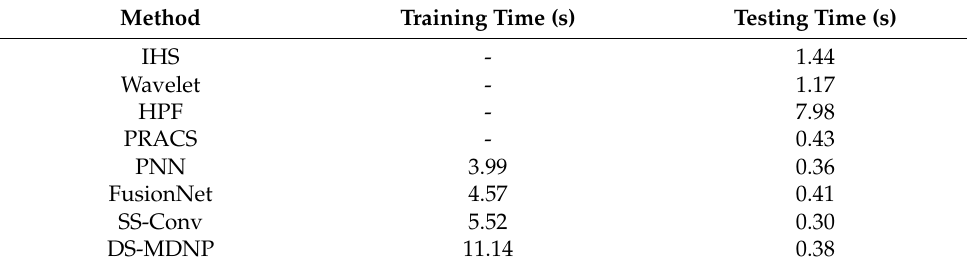
Table 7. Comparison of training and testing times on WorldView-2.